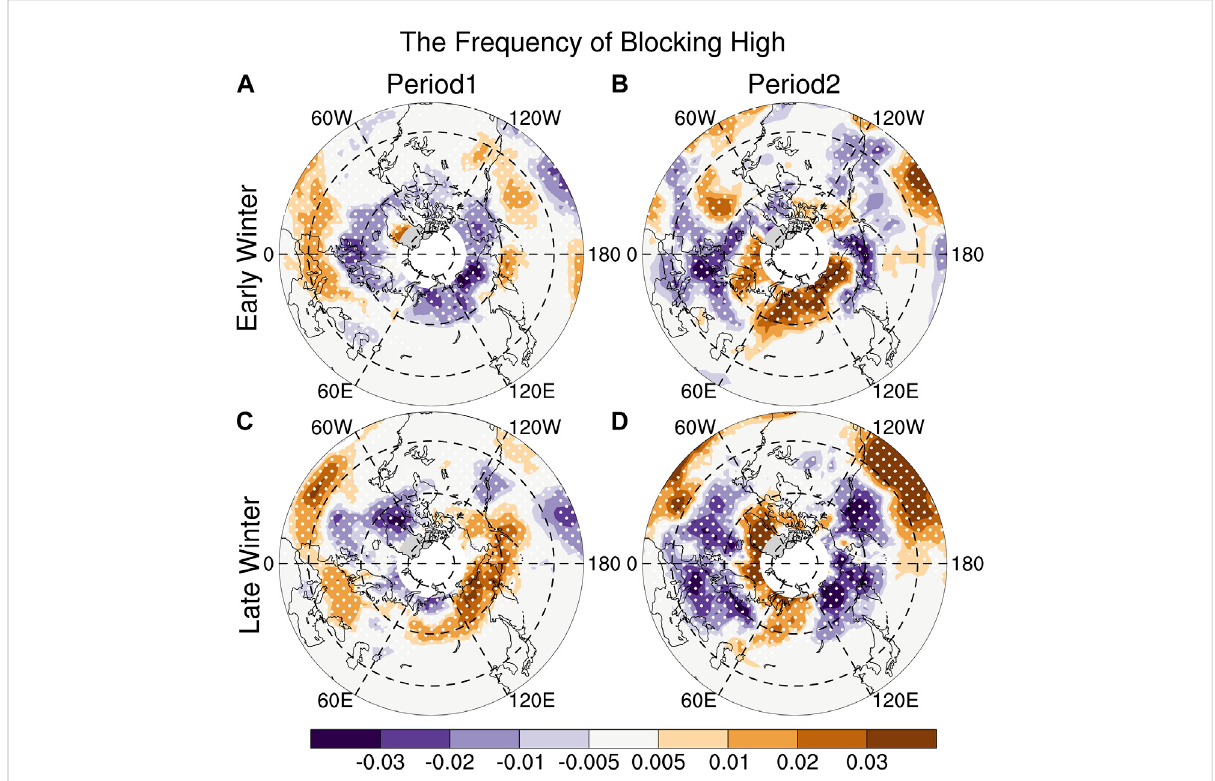
FIGURE 3 Anomalies intheblockinghighat500 hPainearlyandlatewinters. (A) EarlywinterintheP1stage, (B) earlywinterintheP2stage, (C) latewinter intheP1stageand (D) latewinterintheP2stage(units:days).Thewhitedotsrepresent p < 0.05;unitsaredays.Anomaliesisrelativetoclimaticstates (1981 –